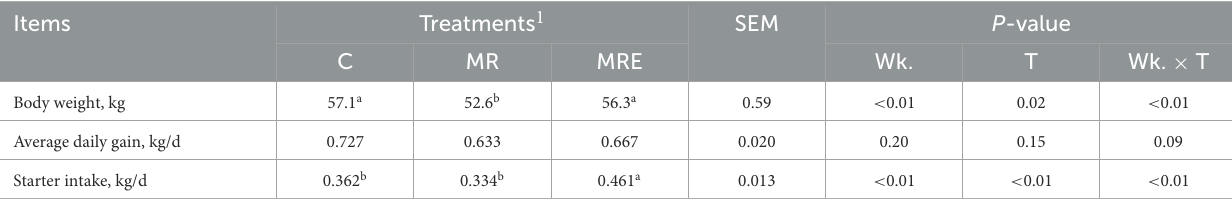
Intake and growth